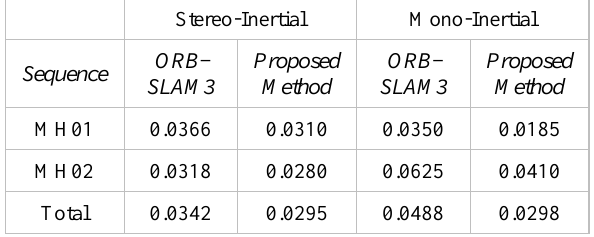
Table 1. Average ATE results of two algorithms applied to the two sequences. Unit: [m].